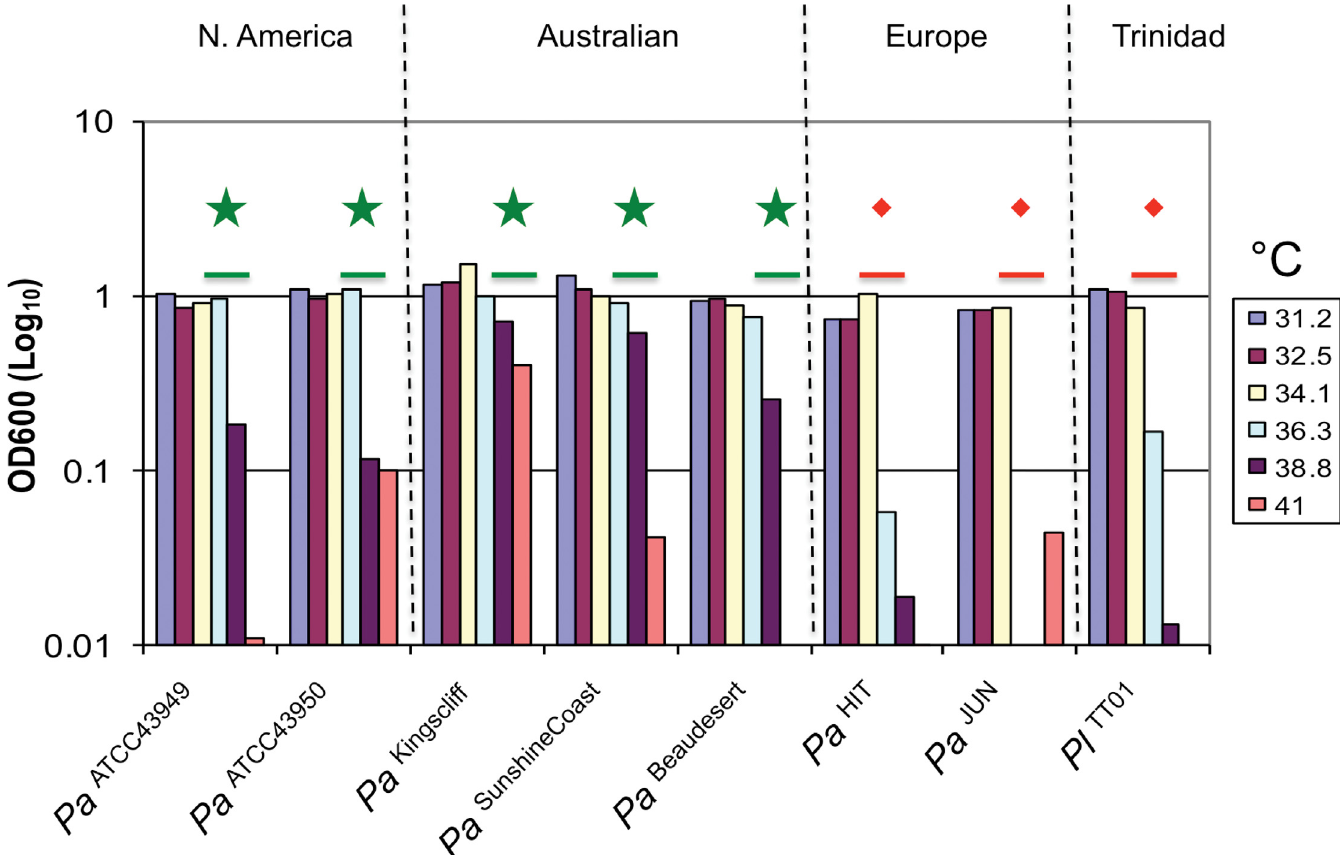
Fig 2. Clinical Photorhabdus isolates are able to survive exposure to higher temperatures than most non-clinical isolates. The optical density achieved by representative strains after overnight growth in static conditions (at 28°C in LB medium) after prior 18 h exposure to a range of temperatures. A range of clinical (N. American and Australian) and non-clinical (European) strains of P . asymbiotica (Pa) were tested, and the well-studied P . luminescens strain ( Pl TT01 ) was included for comparison. Green stars and red diamonds indicate thermal tolerance and intolerance respectively. Pa strain designations are indicated as